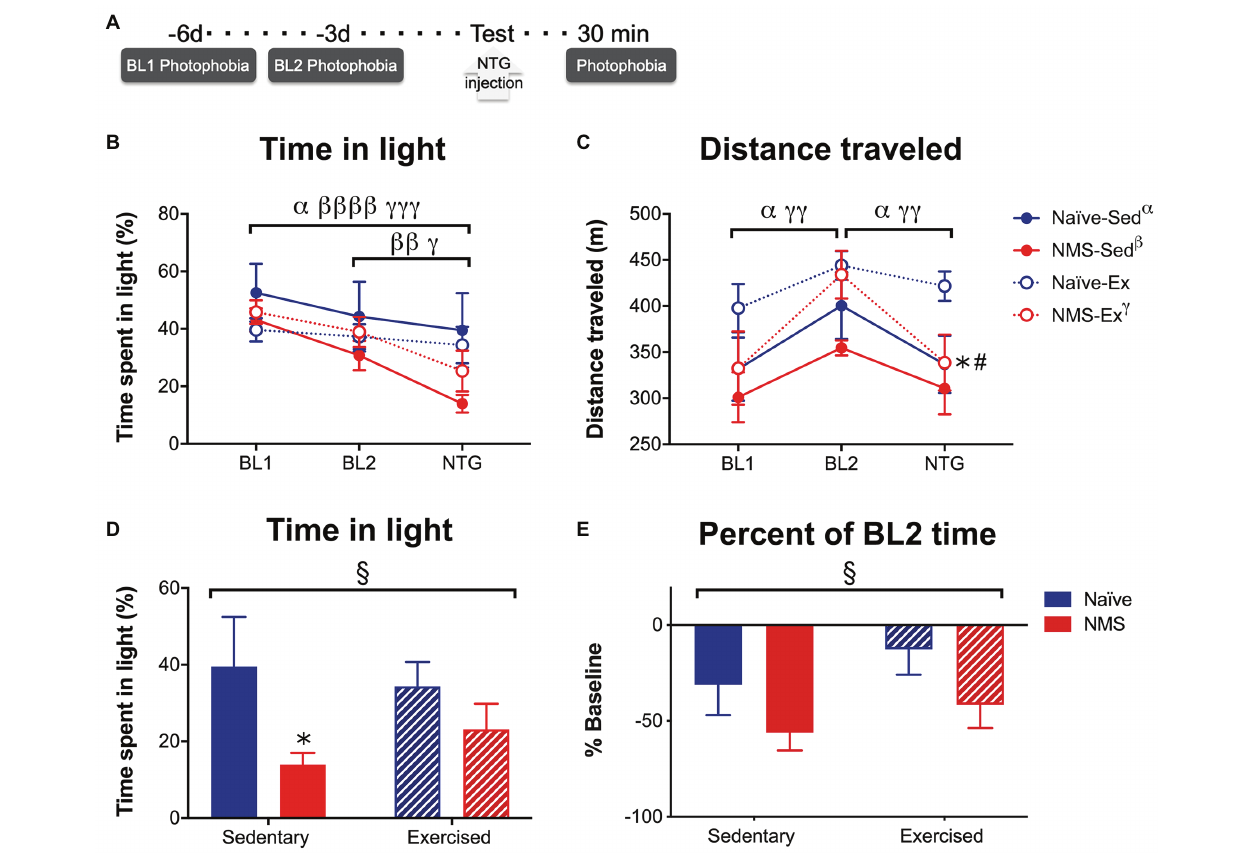
FIGURE 7 | Photophobia-like behavior was measured in Sed and Ex naïve and NMS mice. (A) Light aversion behavior was measured 6 [baseline day 1 (BL1)] and 3 [baseline day 2 (BL2)] days prior to testing day and 30 min after an intraperitoneal NTG injection. (B) The percent of time spent on the light side of a light/dark box was quantified at each time point. A significant overall effect of time ( p < 0.0001) and a NMS/time interaction ( p < 0.05) was observed on the time spent in the light. Between BL1 and the treatment day, naïve-Sed, NMS-Sed, and NMS-Ex mice significantly decreased their time spent in the light side. Both NMS-Sed and NMS-Ex mice significantly decreased their time spent in the light between BL2 and NTG. (C) Total distance traveled was measured during the testing period and there was a significant overall effect of time across all groups ( p < 0.0001). Naïve-Sed and NMS-Ex mice displayed significant changes in their distance traveled from BL1 to BL2 and from BL2 to NTG. On testing day, naïve-Ex mice traveled a significantly farther distance compared to either naïve-Sed or NMS-Ex mice. (D) Comparisons between groups revealed a significant impact of NMS on time in the light side following NTG treatment. NMS-Sed mice spent significantly less time in the light compared to naïve-Sed mice. (E) Likewise, when calculated as a percent of BL2 time spent in the light, there was a significant overall effect of NMS. Brackets indicate significant within-group differences between time points (three-way RM ANOVA, α naïve-Sed, β NMS-Sed, γ naïve-Ex, p < 0.05, 0.01, 0.0001, Fisher’s LSD posttest, A,B ) or NMS ( § p < 0.05) two-way ANOVA. * p < 0.05 vs. naïve, # p < 0.05 vs. sedentary, Fisher’s LSD posttest. n =